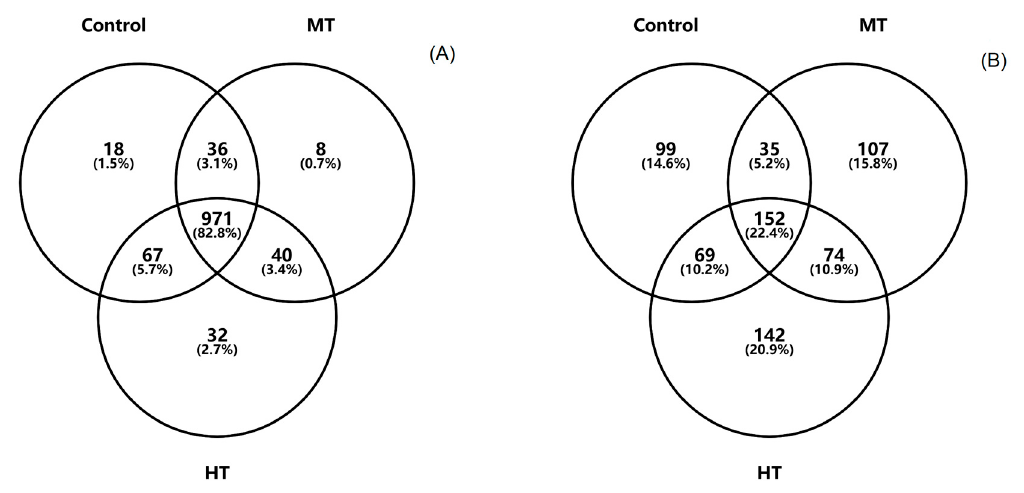
Figure 2. The unique and overlapped OTUs detected in the different treatments for bacterial communities ( A ) and fungal communities ( B ); Control: conventional management model, MT: moderate thinning, and HT: heavy thinning. 6